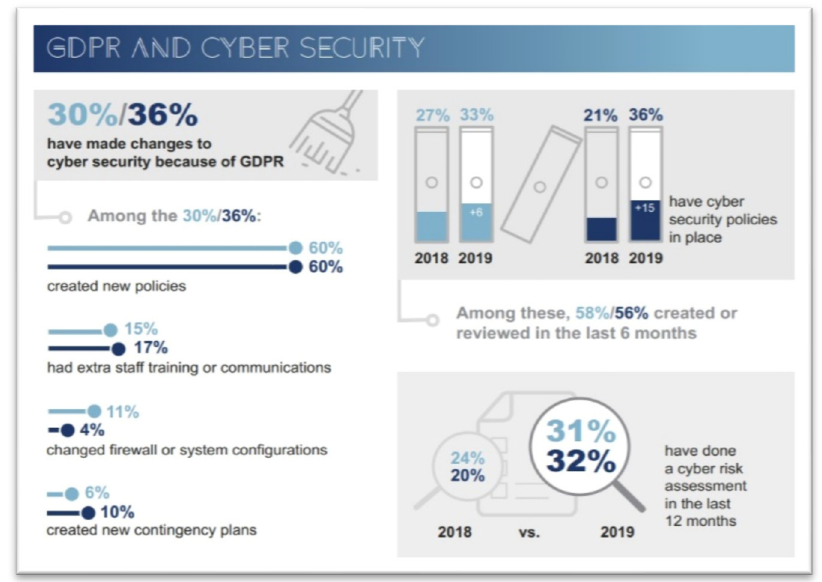
Figure 2. GDPR and Cybersecurity [23].